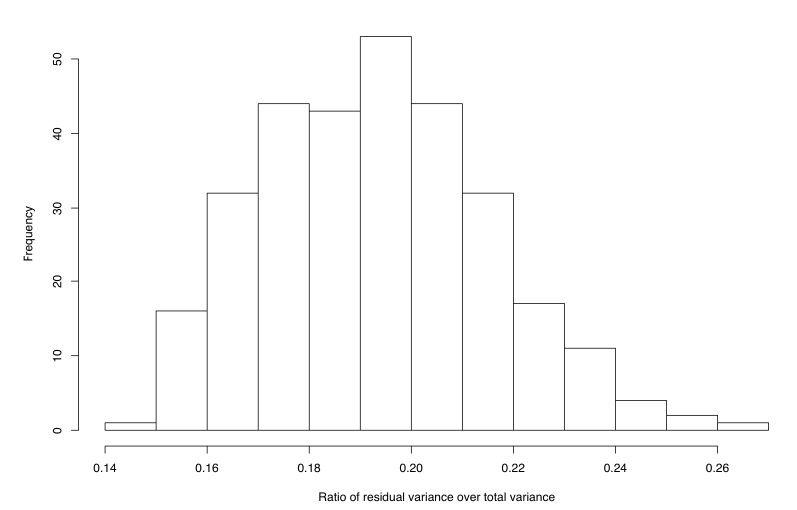
Figure 2 – Histogram of the values of residual variance (4), as percentage of total variance for 300 randomly selected subsets of 10